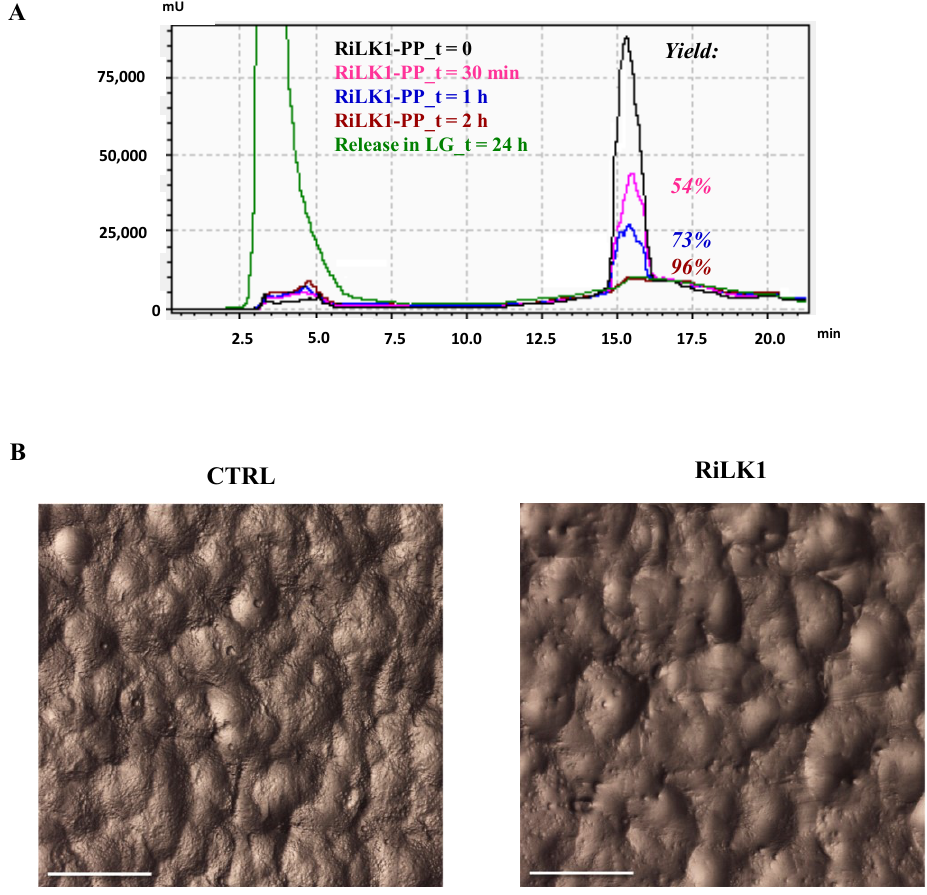
Figure 9. Covalent immobilization of RiLK1 on polypropylene (PP) disks. ( A ) Time course of the coupling reactions of RiLK1 on PP surface determined by RP-HPLC on µ Bondapak C18 column for the immobilization yield (%) measurement. The PP disks, pre-activated by corona treatment, were incubated for di ff erent times in a solution of RiLK1 (50 µ M) in DMSO in presence of molecular sieves. After each coupling reaction, the solutions were recovered and analyzed by RP-HPLC. A reference sample (t = 0) prepared with the same peptide solution placed in contact with PP films without adding the molecular sieves was used as control. The chromatogram is representative of three independent experiments. The chromatographic profile in green represents the release analysis of RiLK1 from functionalized PP disks performed by RP-HPLC on C18 column after 24 h incubation at 4 ◦ C in mozzarella brine. A solution of RiLK1 (50 µ M) was used as control. ( B ) Stereomicroscope photographs of PP disks without (CTRL) and with the peptide (RiLK1) after the immobilization procedure. The microscope images are representative of three independent experiments performed in triplicate. Bar is equal 0.5